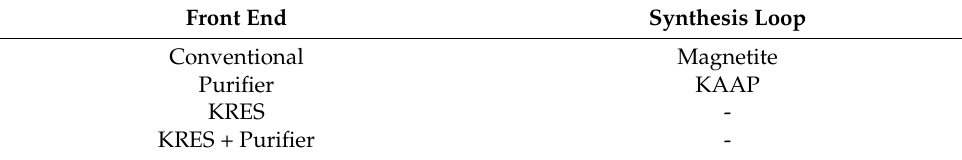
Table 2. KBR ammonia plant flow sheet options.